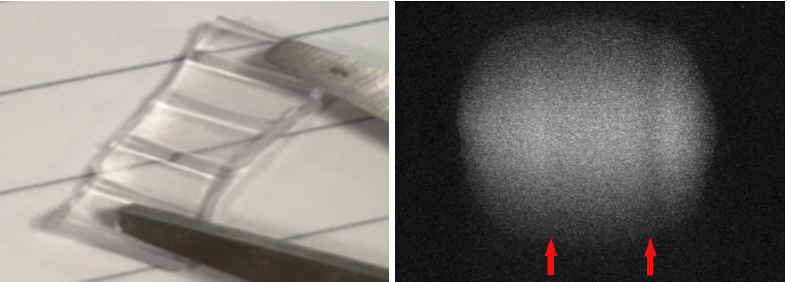
Figure 3. ( Left ): A segment of the waste fluid tube. Reinforcement ribs are running along the tube. The ribs significantly change the optical pass of light traveling through the tube. ( Right ): Acquired sensor image with marked artifacts caused by reinforcements. The horizontal location of the shadows depends on the tube placement and cannot be controlled. We note that the right figure was intensity adjusted for better depiction, which amplified intensity variations in the vertical direction as well as the noise level.